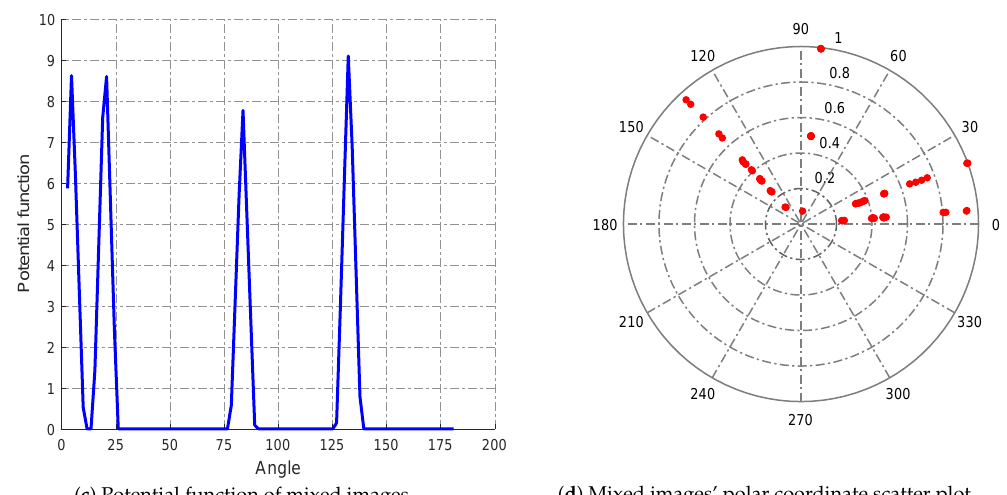
( d ) Mixed images’ polar coordinate scatter plot Figure 13. Clustering